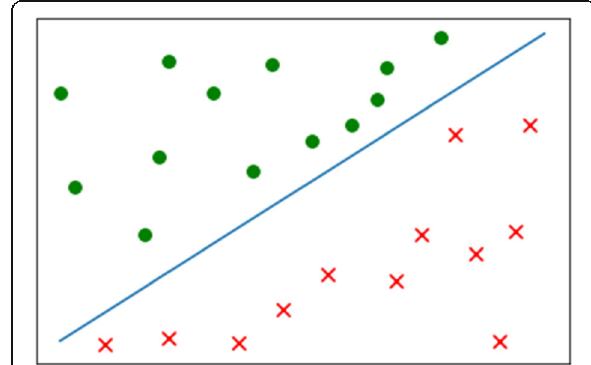
Fig. 2 The principle of SVM hyperplane in two-dimensional space.